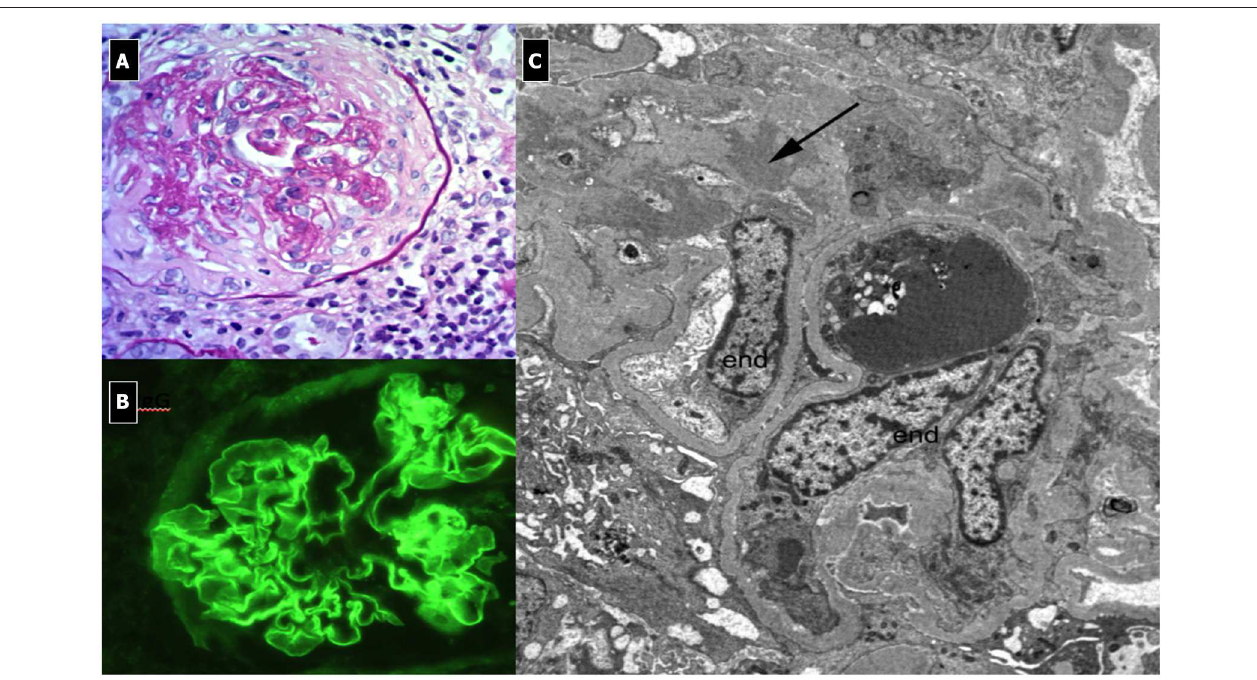
FIGURE 10 | Rapidly Progressive Glomerulonephritis due to anti-GBM antibodies. (A) LM (PAS Stain); membranoproliferative, crescentic and sclerotic pattern associated with interstitial infiltration of leukocytes (endo-extracapillary pattern). (B) IF: Linear deposits of IgG along the capillary wall. (C) EM: shows no deposits and the presence of